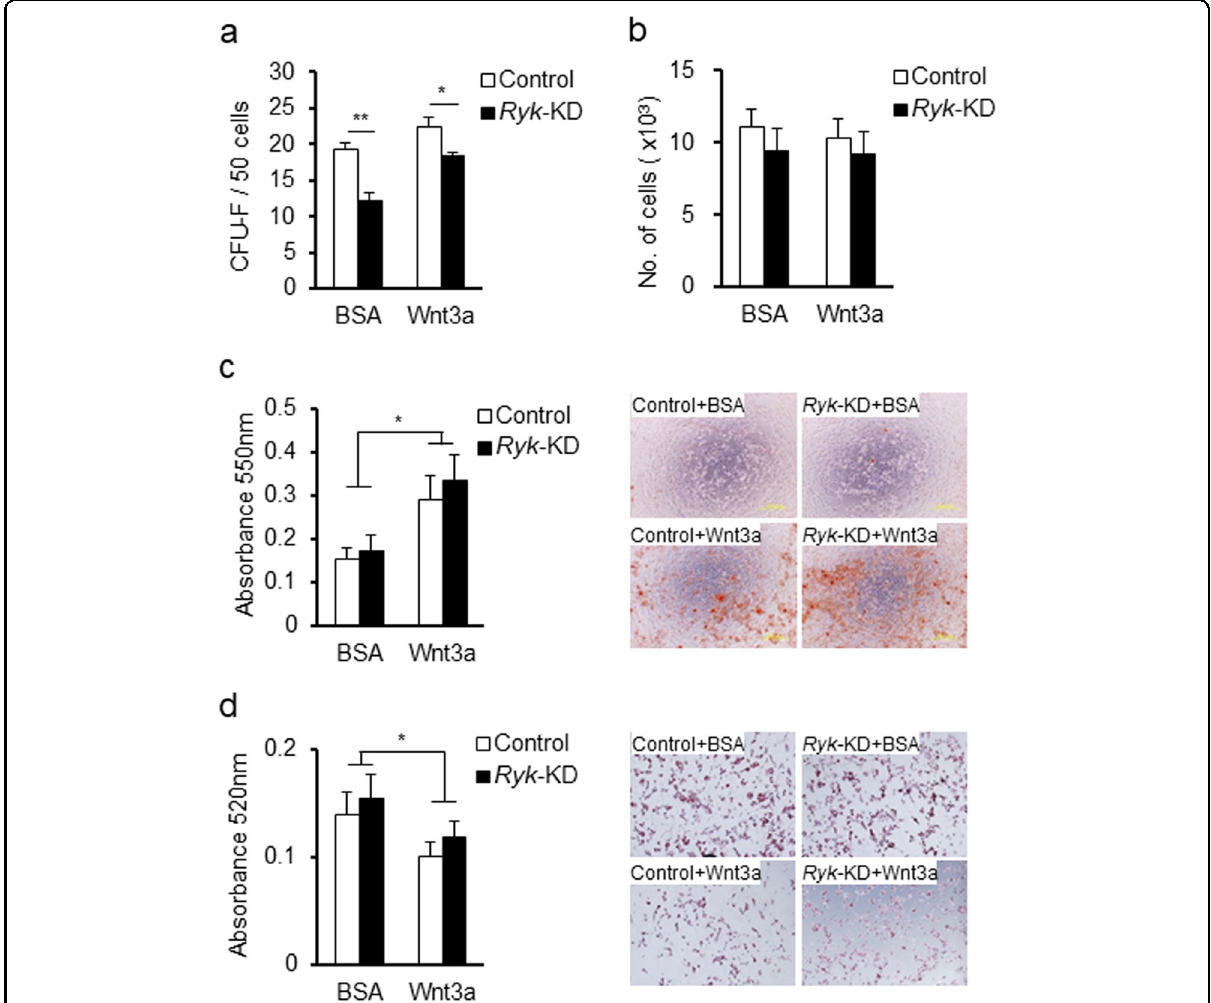
Fig. 2 Effects of Ryk knockdown on the Wnt-responsive cellular function of mMSCs. a Effect of Ryk -KD on the frequency of mesenchymal progenitors in the mMSCs treated with Wnt3a. The numbers of colony forming unit- fi broblasts (CFU-F) from 50 plated cells are shown. b Effect of Ryk -KD on the proliferation of mMSCs. The number of cells in each indicated condition was measured 3 days after plating (2 × 10 3 cells). c , d Effects of Ryk -KD on the differentiation of mMSCs. The control or Ryk -KD mMSCs were induced to differentiate into osteogenic or adipogenic lineages in the presence or absence of the Wnt3a ligand (10ng/ml). The effect on osteogenic differentiation was measured by Alizarin Red S staining, as shown by representative images (right panel), and quanti fi cation by absorbance at 550 nm (left panel). Effects on adipogenic differentiation were measured by fat- droplet Oil Red O staining with images (right panel) and quanti fi cation by absorbance at 520nm (left panel) (mean± SEM, * p <0.05, ** p <0.01, n =